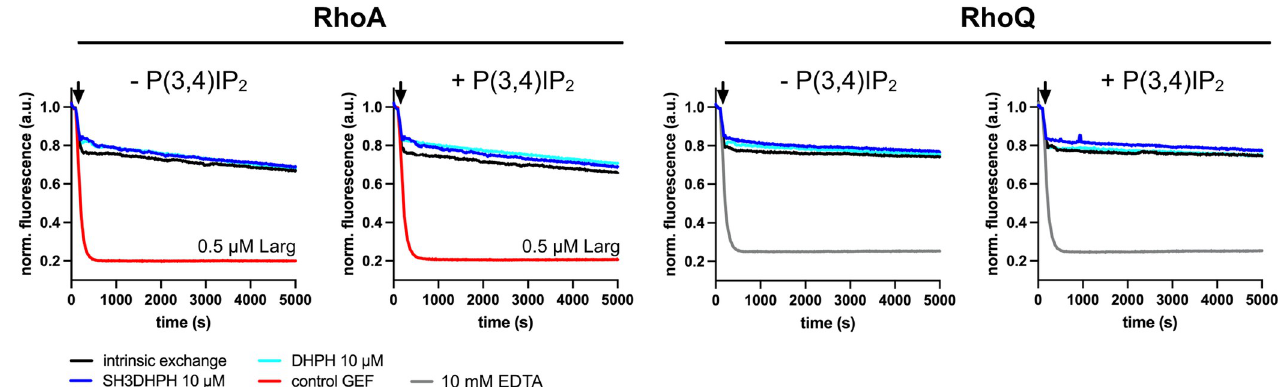
Fig 5. Guanosine nucleotide exchange factor activity of obscurin RhoGEF fragments in absence or presence of 10 μ M P(3,4)IP 2 towards RhoA and RhoQ/TC10. Black arrows indicate addition of buffer/GEF/EDTA. Data represent mean of n = 3 experiments.